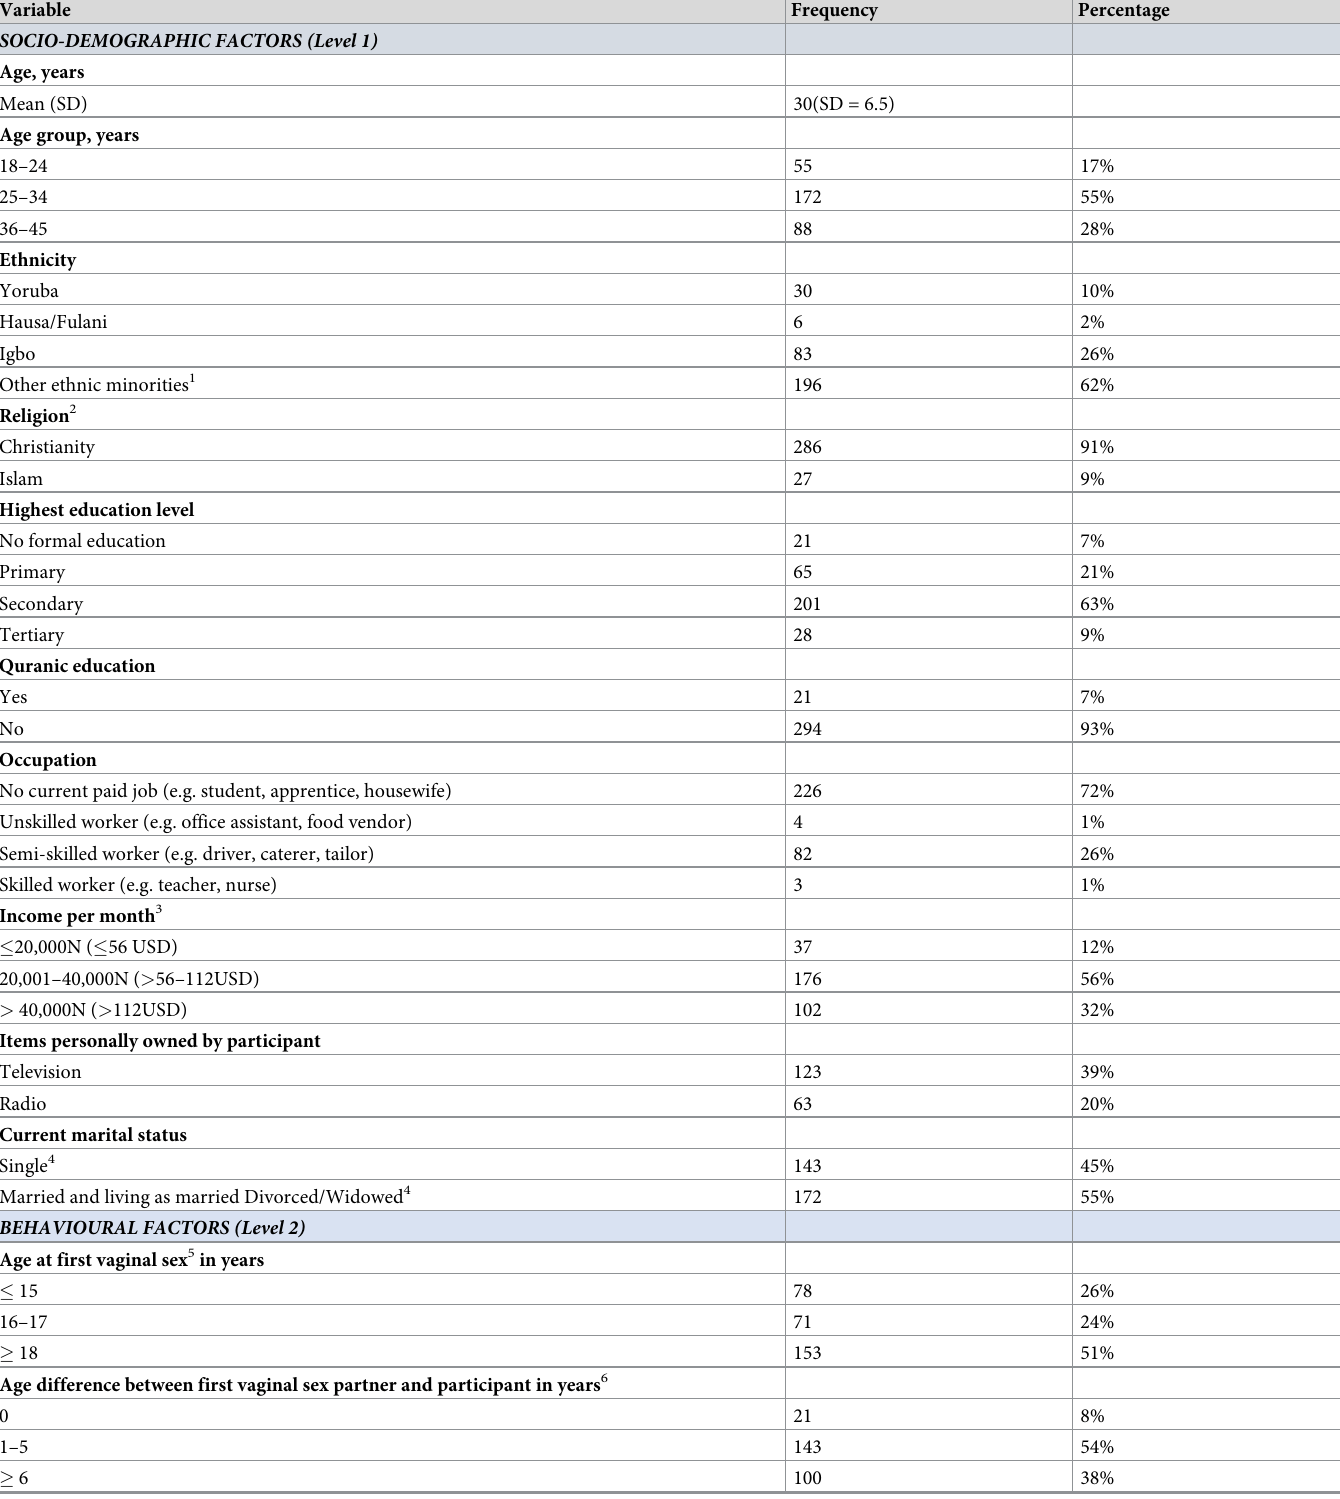
Table 1. Socio-demographic characteristics of brothel-based female sex workers in Ibadan, Nigeria (n = 315).